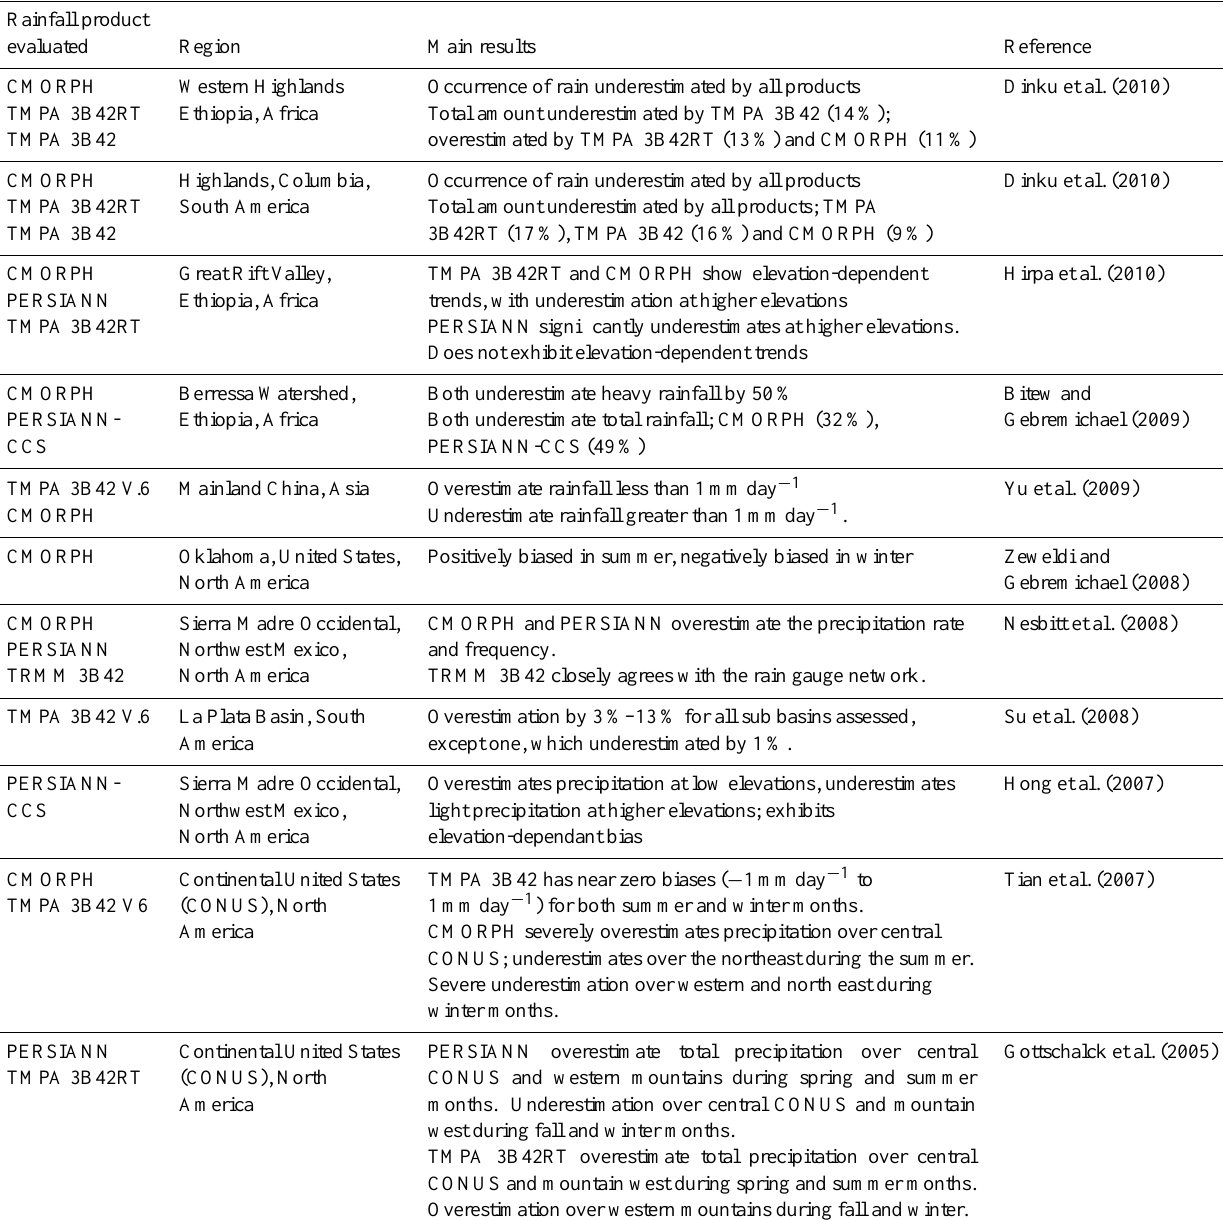
Table 1. Evaluations on High Resolution Satellite